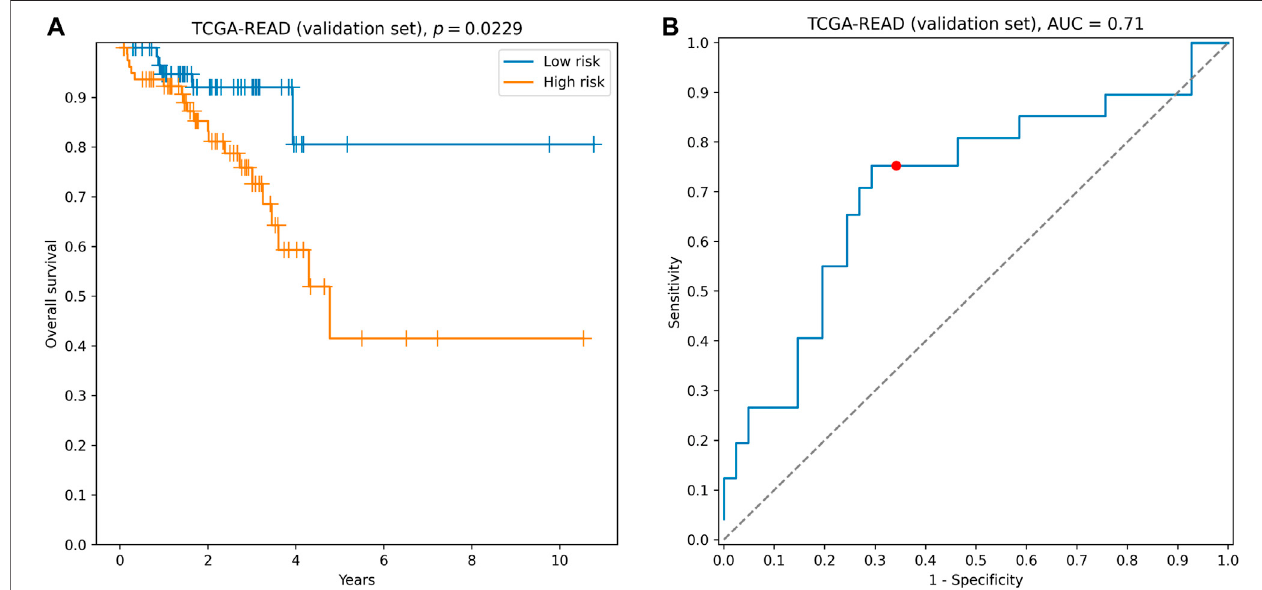
FIGURE3| Performanceofhsa-miR-32-5p | 0,NR1H2,andSNAI1signatureonthevalidationset. (A) Kaplan – Meiercurves. (B) 3-yearROCcurve.Redpointonthe ROC curve corresponds to the risk score threshold, calculated as a median score on the training set.